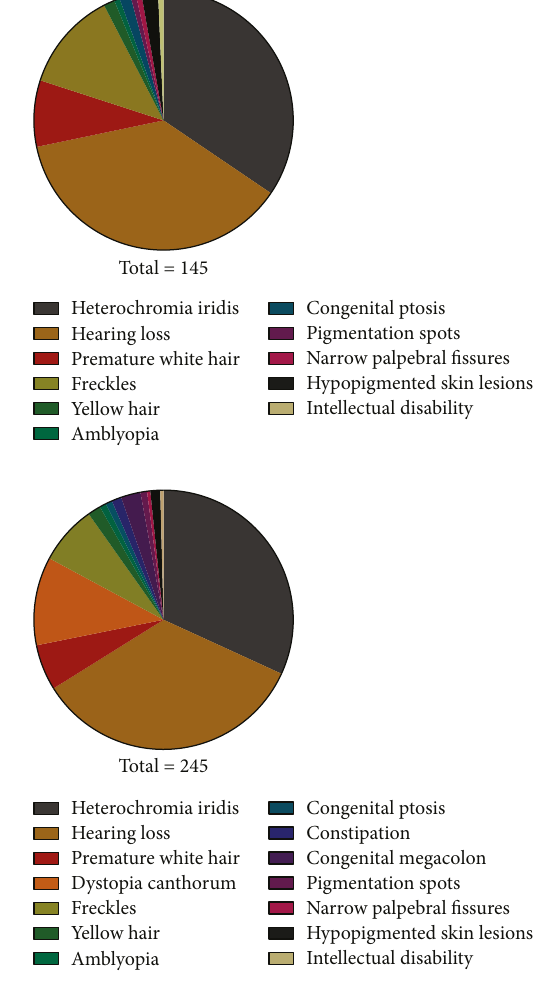
Figure 3: The proportion of phenotypes detected in WS types 1, 2, and 4. Dystopia canthorum was the most frequent sign in WS type 1 (100%, 27/27), followed by sensorineural hearing loss (88.9%, 24/27), heterochromia iridis (81.5%, 22/27), hair hypopigmentation (14.8%, 4/27), constipation (1/27, 3.7%), and pigmentation spots (1/27, 3.7%). In WS type 2, sensorineural deafness (94.7%, 54/57) and heterochromia iridis (87.7%, 50/57) were still the most common clinical signs and symptoms, followed by freckles (31.6%, 18/57), hair hypopigmentation (24.6%, 14/57), hypopigmented skin lesions (5.3%, 3/57), and congenital ptosis (3.5%, 2/57). Amblyopia (1.8%, 1/57), congenital ptosis (1.8%, 1/57), and narrow palpebral fi ssures (1.8%, 1/57) are rare and unique symptoms in WS type 2 in the Chinese